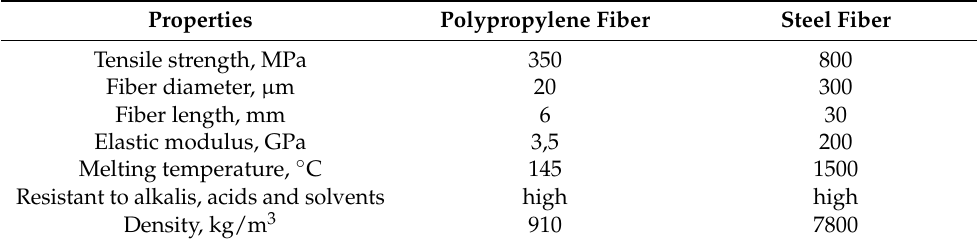
Table 1. Mix proportions.